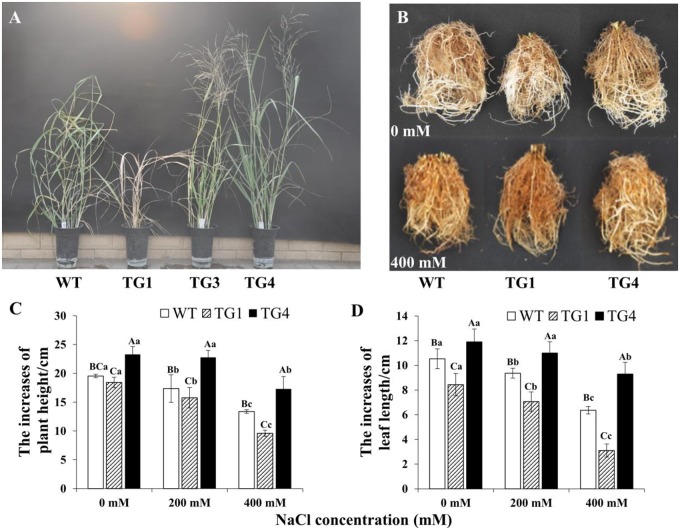
The salt tolerant evaluation of TG1, TG4 and WT plants.(A) Phenotypic characterization of TG1, TG4 and WT plants under 400 mM NaCl treatment on the 30th day. (B) Roots of TG1, TG4 and WT under 0 and 400 mM NaCl on the 30th day. (C) The increases of plant height, (D) the increases of leaf length in TG1, TG4 and WT under 0, 200 and 400 mM NaCl treatment for 30 days. Value are mean ± SE (n = 9). The significance of treatment (0, 200 and 400 mM NaCl concentration) an sample type (WT and transgenic plants) was tested at the P < 0.05 level (two way ANOVA), capital letter represents the difference between WT and transgenic plants under the same salt concentration, lowercase represents the difference of WT or transgenic plants under 0, 200 and 400 mM NaCl concentration.